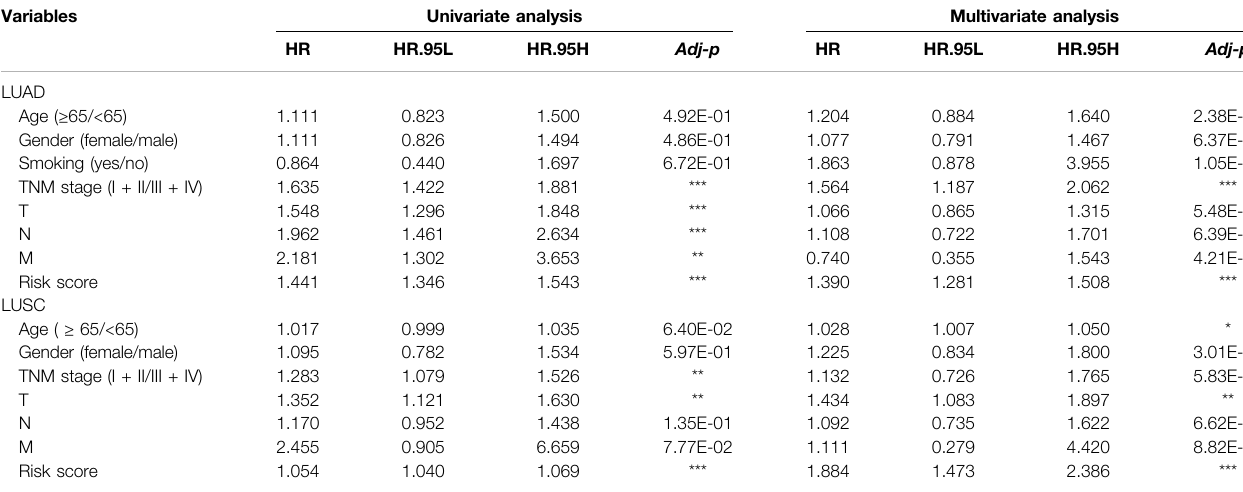
TABLE 1 | The univariate and multivariate cox regression analysis of clinicopathological data from TCGA-LUAD and LUSC.